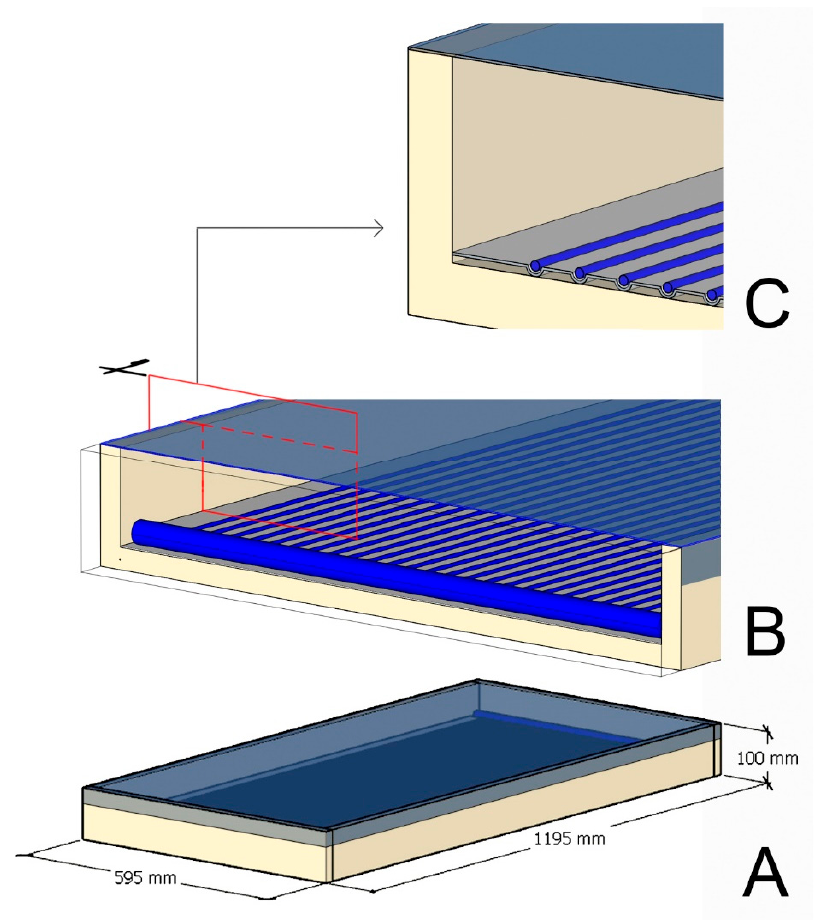
Figure 14. A condensation-resistant radiant cooling panel: ( A ) A complete panel and total dimensions; ( B ) Panel section; ( C ) Panel section detail. Source: First author.